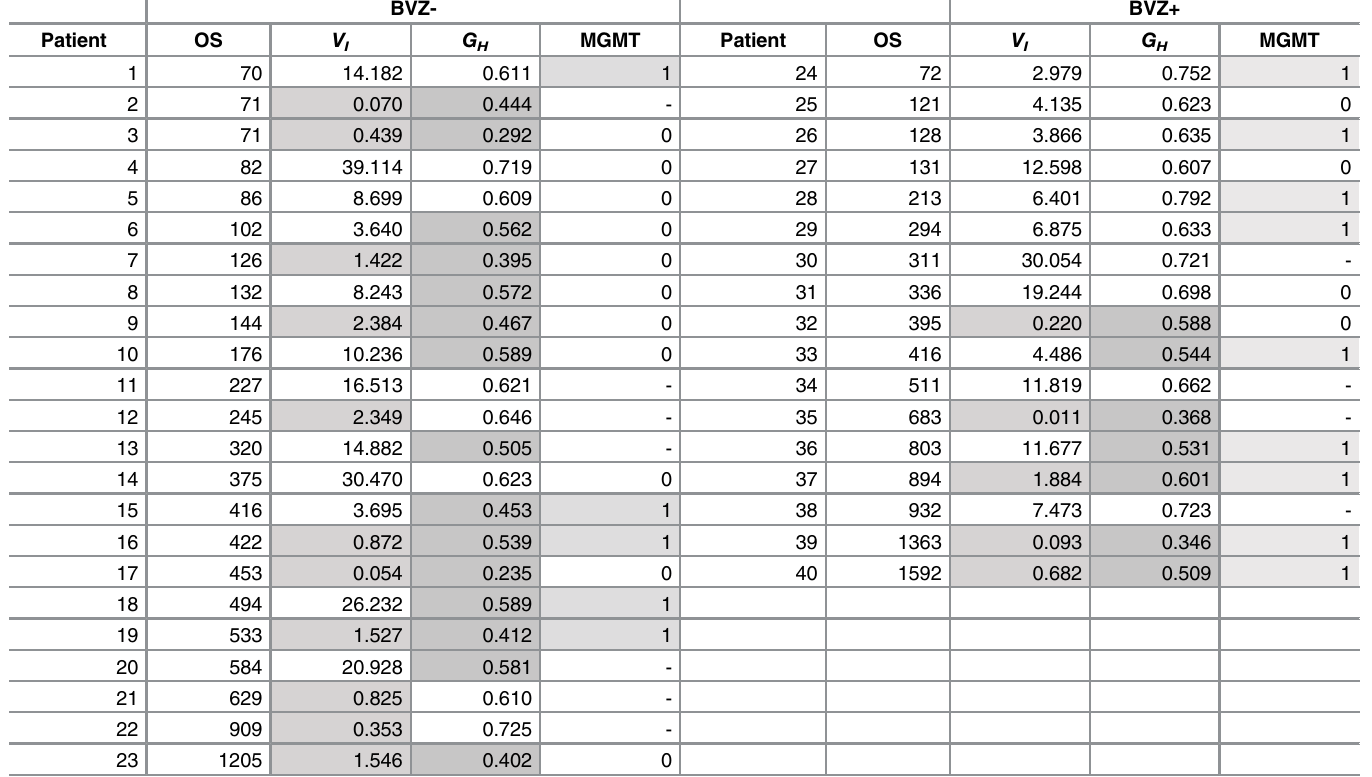
Table 6. Overall survival, G H , V I and MGMT status (when available) for all of the patients included in the study. Within each group (BVZ+ or BVZ-) patients are ordered by survival. Grey cells indicate patients in the favourable groups: either small G H (dark grey) or unmethilated MGMT (light grey). BVZ-